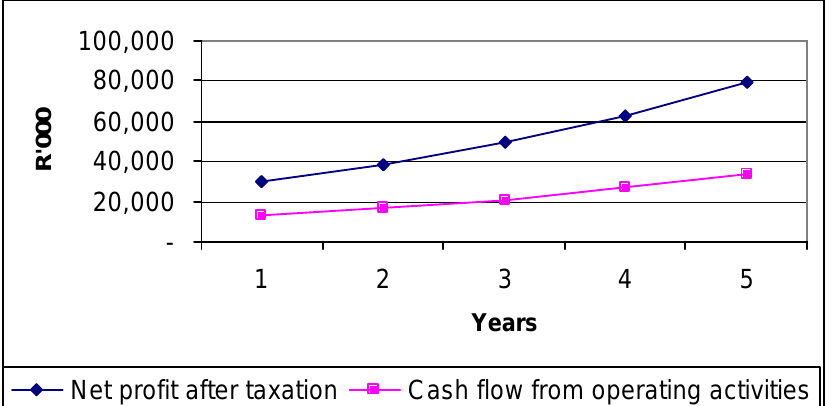
Figure 2: A high growth rate, high non-cash working capital and a high net profit